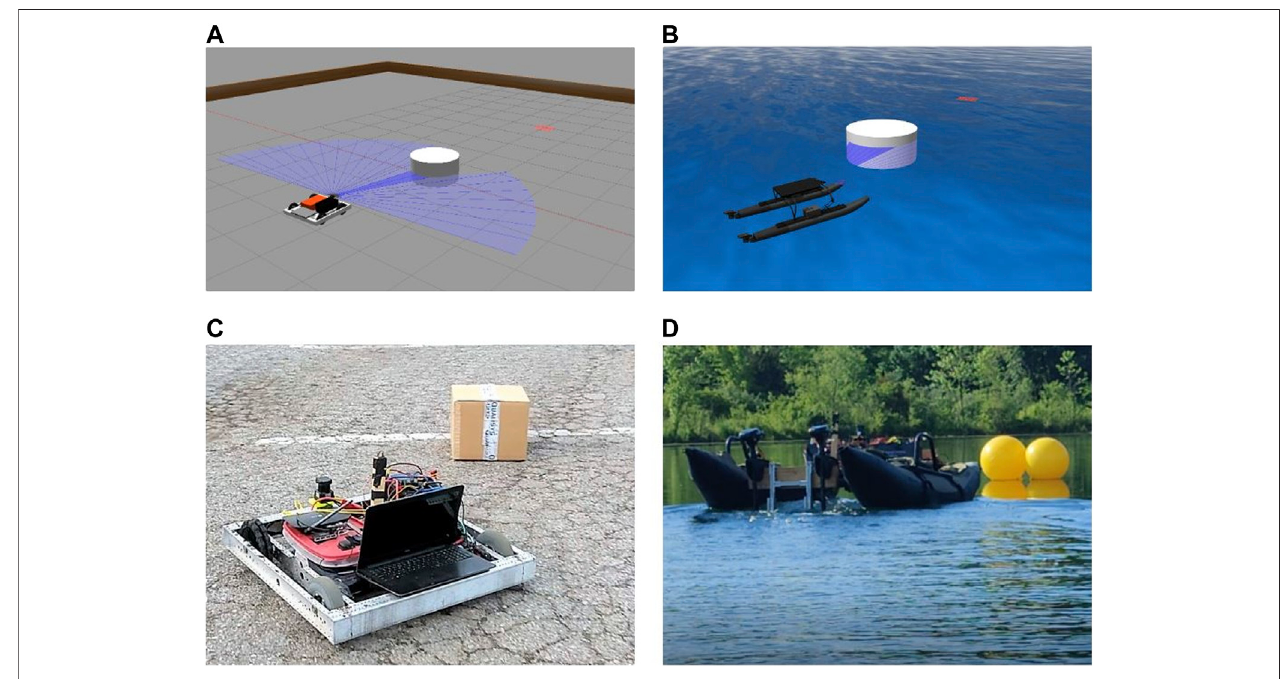
FIGURE 1 | Trained DQN model performing cross-domain obstacle avoidance during (A) an AGV simulation, (B) ASV simulation, (C) AGV real-world mission, and (D) ASV real-world mission. All images show execution of the same trained DRL agent.